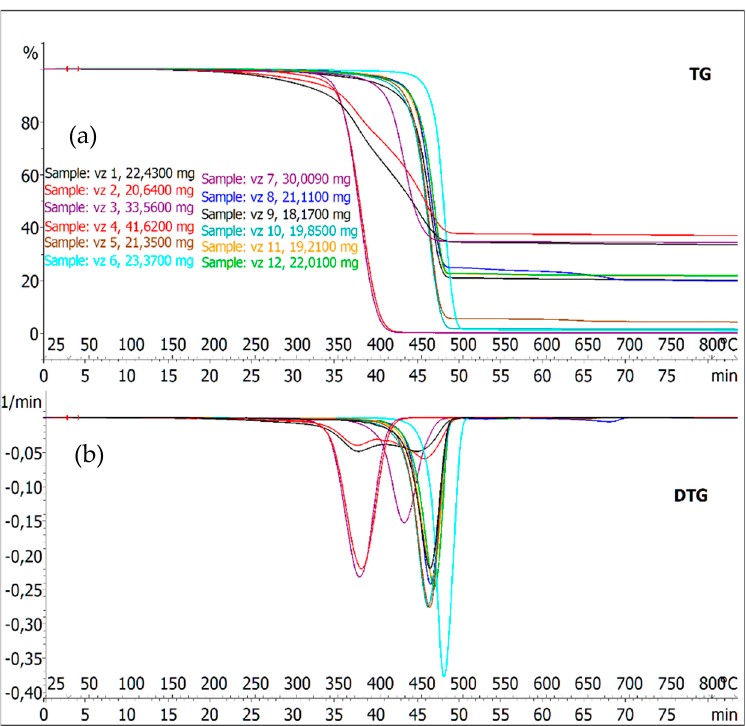
Figure 1. ( a ) Dynamic thermogravimetric curves (TG) of samples in an inert atmosphere, ( b ) derivation of thermogravimetric curves (DTG).